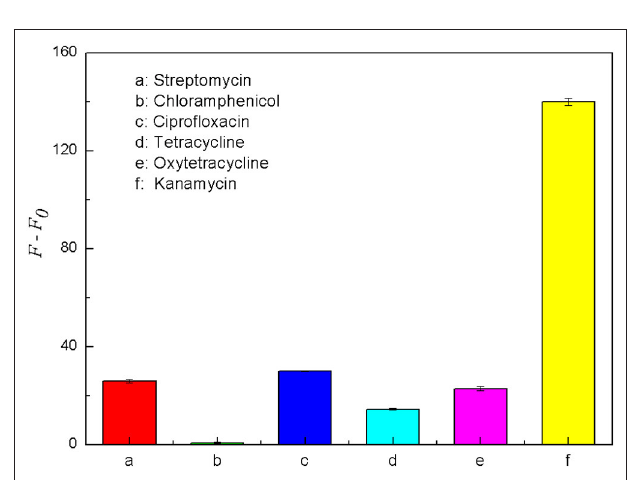
FIGURE 7 | Optimization of reaction time between kanamycin and FDNA. FDNA, 0.05 µ M; QDNA2, 0.1 µ M; kanamycin, 500nM.